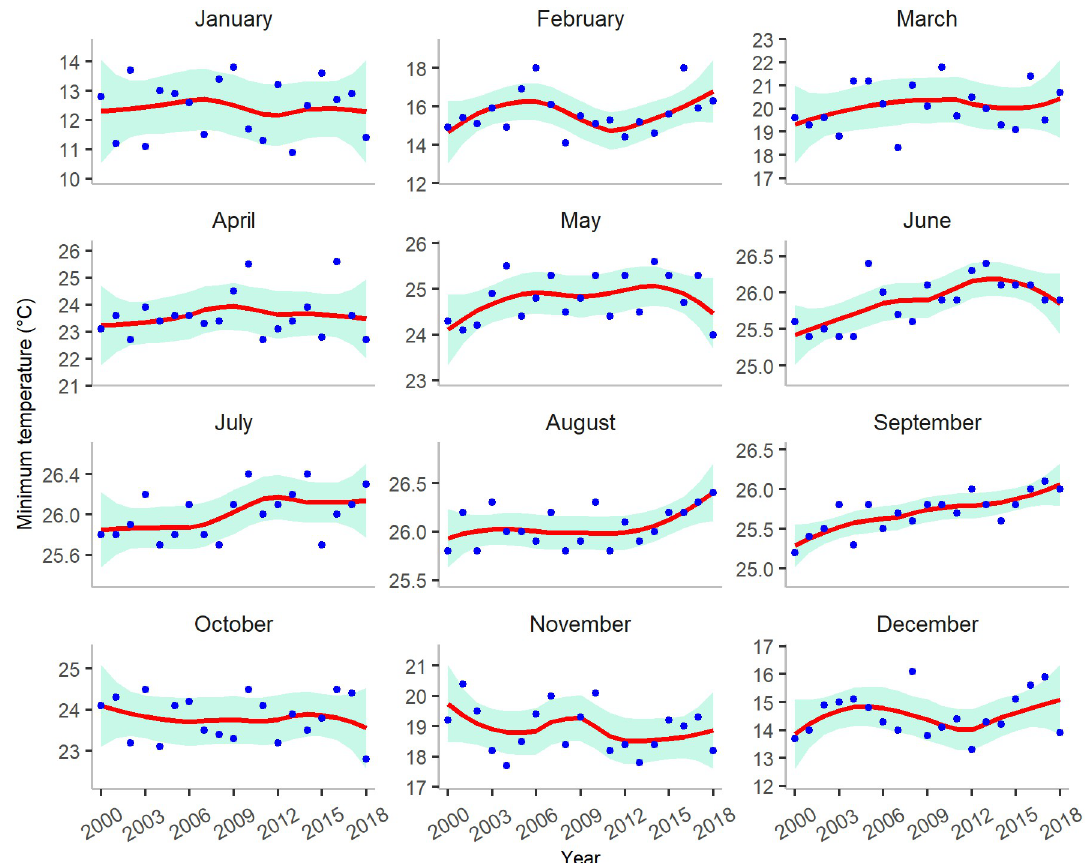
Fig 4. Minimum temperatures (in ˚ C ) in Bangladesh between January 2000 and December 2018. A LOESS smoothing function is used to obtain a smooth line to represent the trend over the years. The shaded region represents the 95% confidence interval. Dots represent the average minimum temperature of a given month for a particular year.